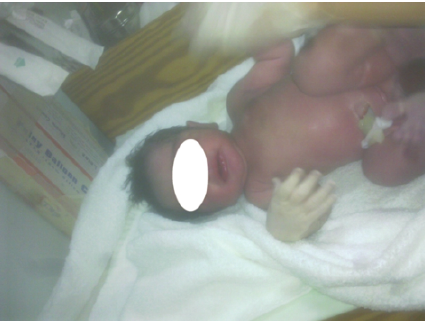
Figure 1: Our patient at age of 6 hours showing pallor and cyanosis from proximal one third of arm to all hands and fingers.